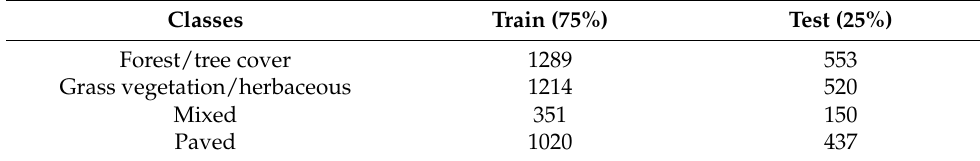
Table 2. Size of training and test sets for each class. Classes Train (75%) Test (25%) Forest/tree cover 1289 553 Grass vegetation/herbaceous 1214 520 Mixed 351 150 Paved 1020